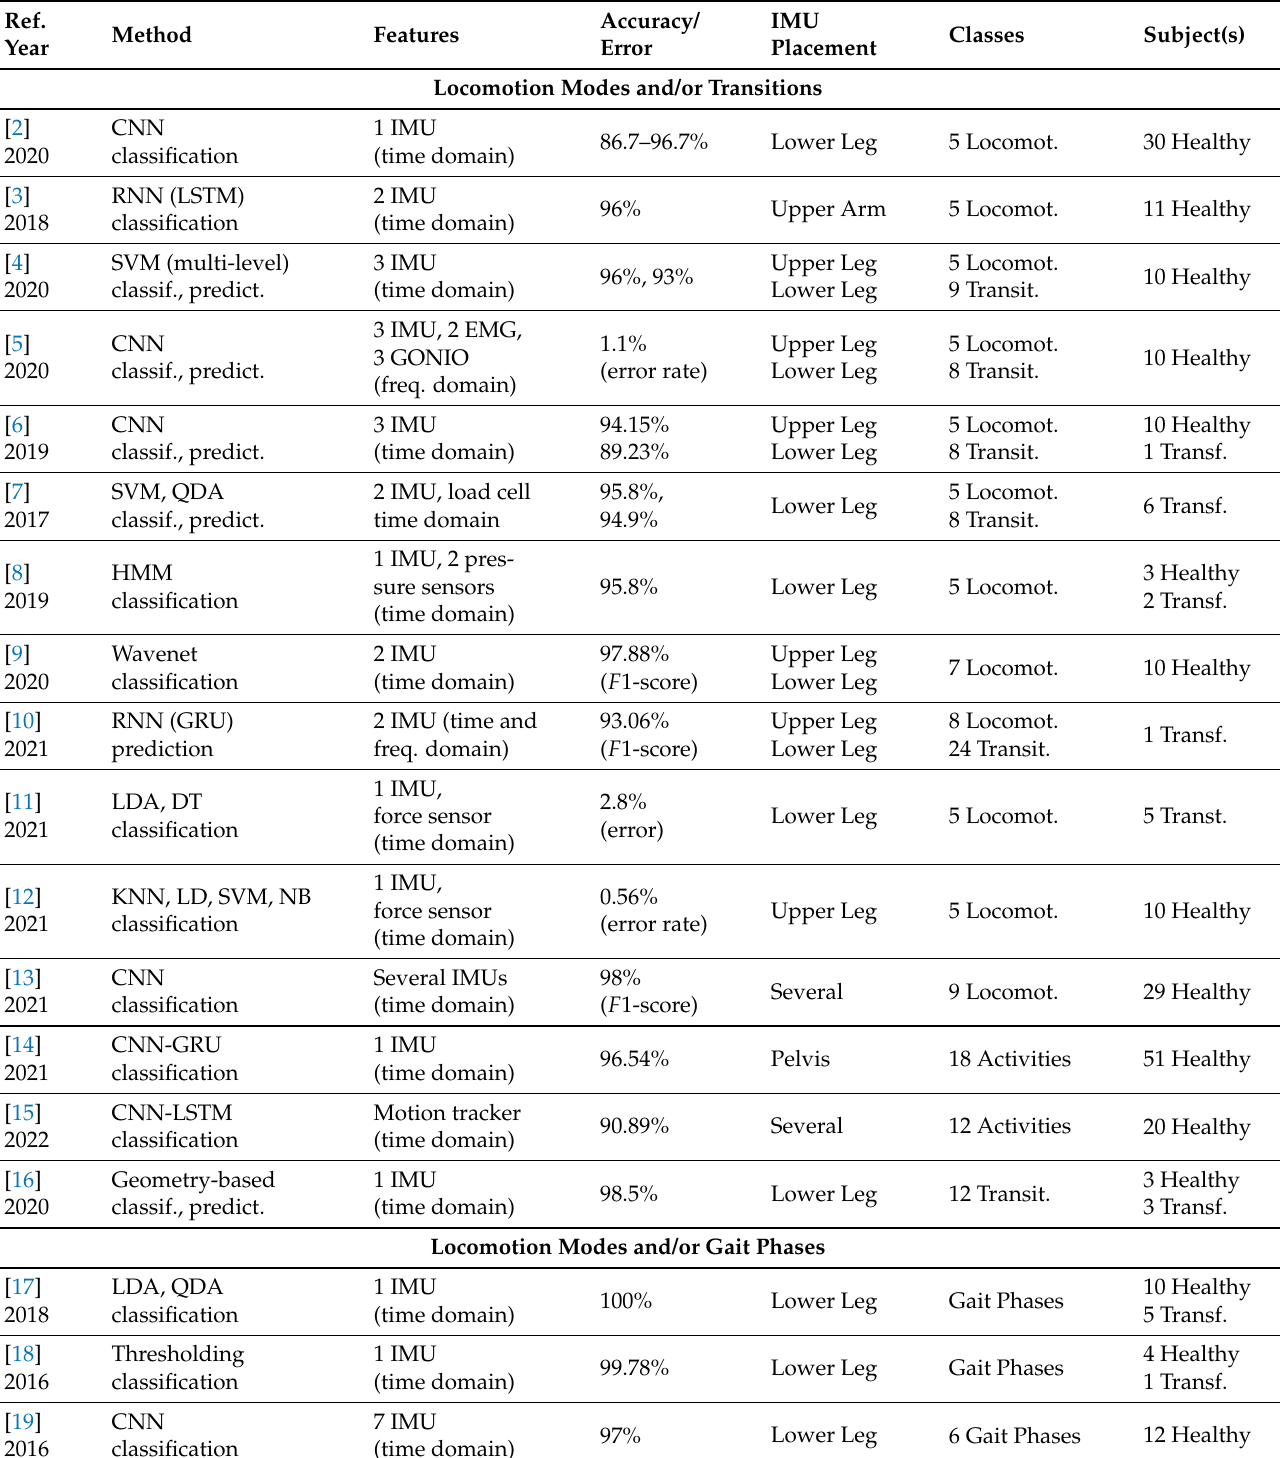
Table 1. State of the art of machine learning and deep learning techniques for the classification and/or prediction of (loco-)motion modes, transitions, and gait phases by means of IMU data of healthy and/or impaired subjects. (CNN: convolutional neural network; RNN: recurrent neural network; LSTM: long short-term memory; SVM: support vector machine; QDA: quadratic discriminant analysis; HMM: hidden Markov models; GRU: gated recurrent unit; LDA: linear discriminant analysis; DT: decision trees; KNN: k-nearest neighbors; NB: naive